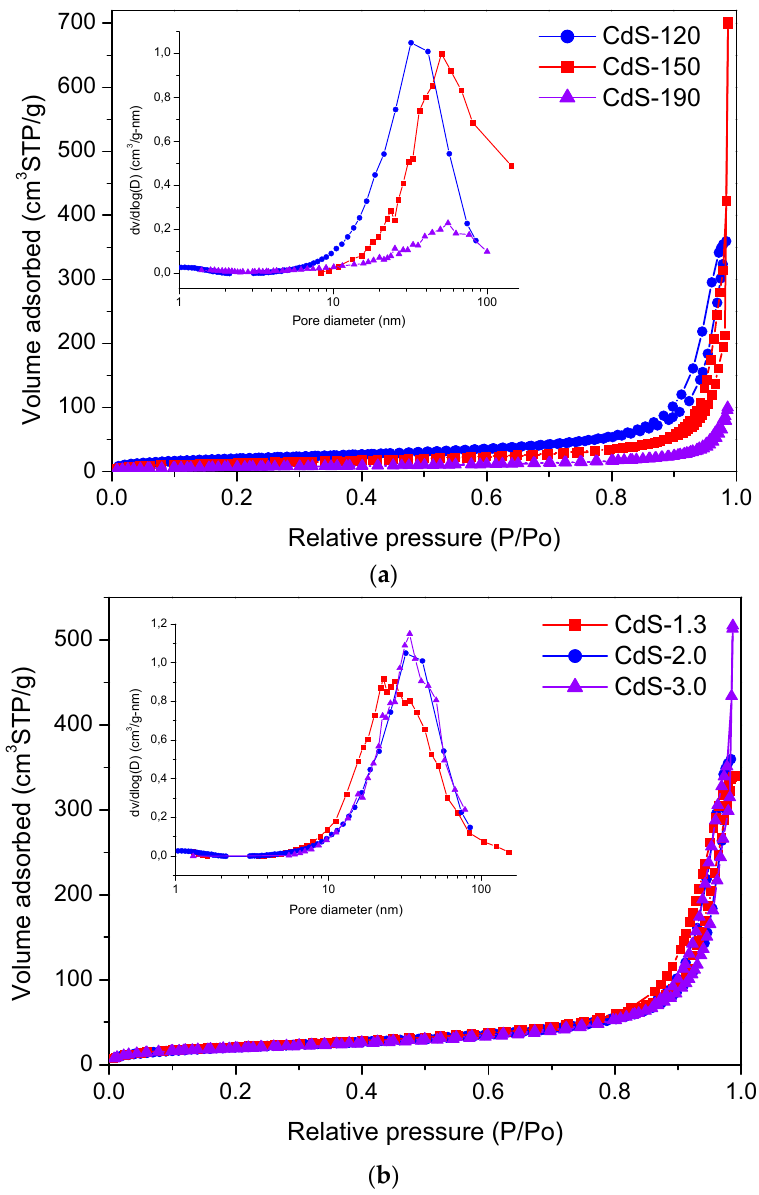
Figure 1. N 2 adsorption-desorption isotherms and the corresponding pore size distribution curves (inset) of the CdS samples: ( a ) influence of solvothermal temperature (CdS-120, 150 and 190); ( b ) influence of H 2 O/thiourea ratio (CdS-1.3, 2.0 and 3.0).